Question: Looking at the figure, what chart type is it?
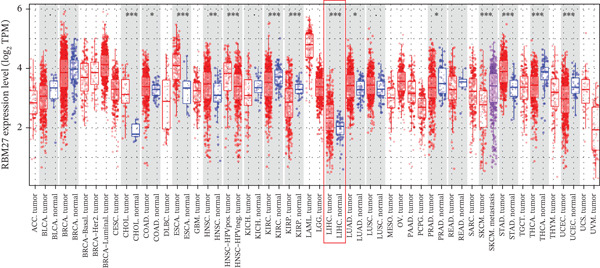
Answer: line